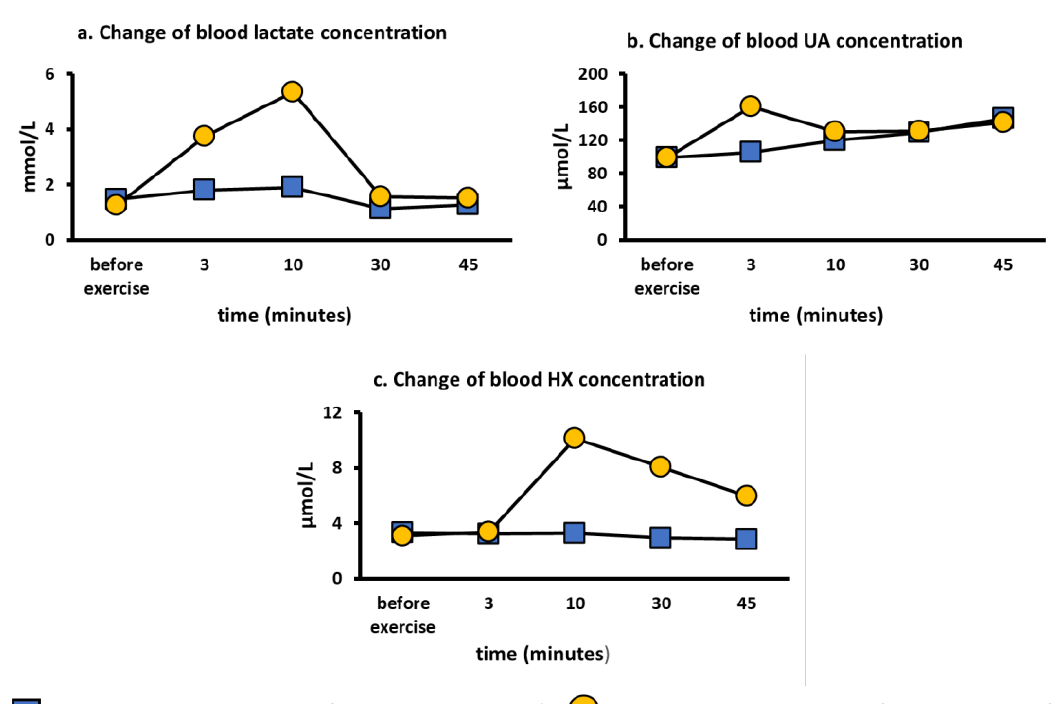
Figure 2. Change of blood lactate, hypoxanthine, and UA concentration on the loading and non- loading sides. HX, hypoxanthine; UA, uric acid. ( a ): Change of blood lactate concentration over time on the loading and non-loading sides. ( b ): Change of blood UA concentration over time on the load- ing and non-loading sides. ( c ): Change of blood HX concentration over time on the loading and non- loading sides.